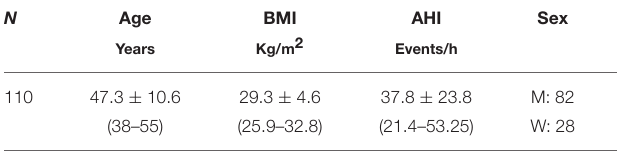
TABLE 1 | Demographic